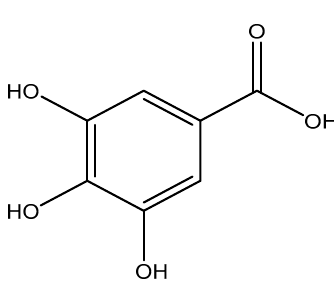
Figure 1. Molecular structure of gallic acid (2,3,4-trihydroxybenzoic acid).